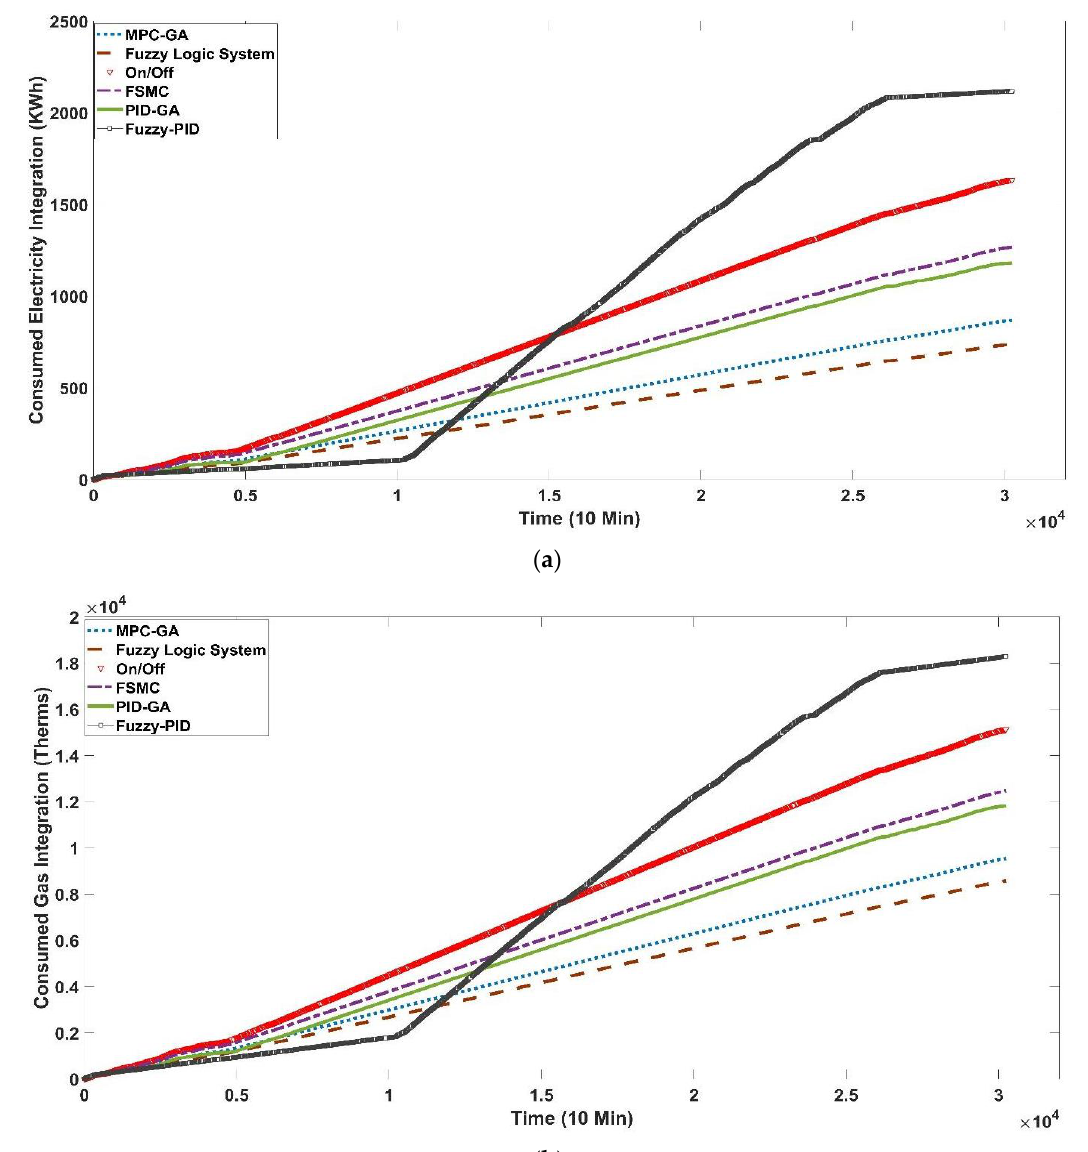
Figure 12. Consumed Energy of steam system by application of different control methods. ( a ) Elec- tricity (kWh = 3600 kJ), ( b ) Gas (Therms = 105,480 kJ).